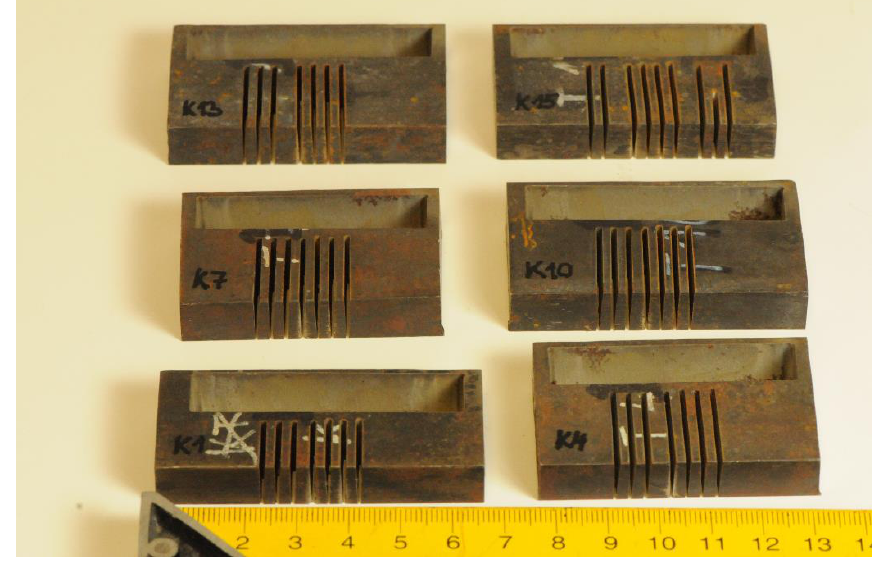
Figure 5. Samples after cutting for force measurement.